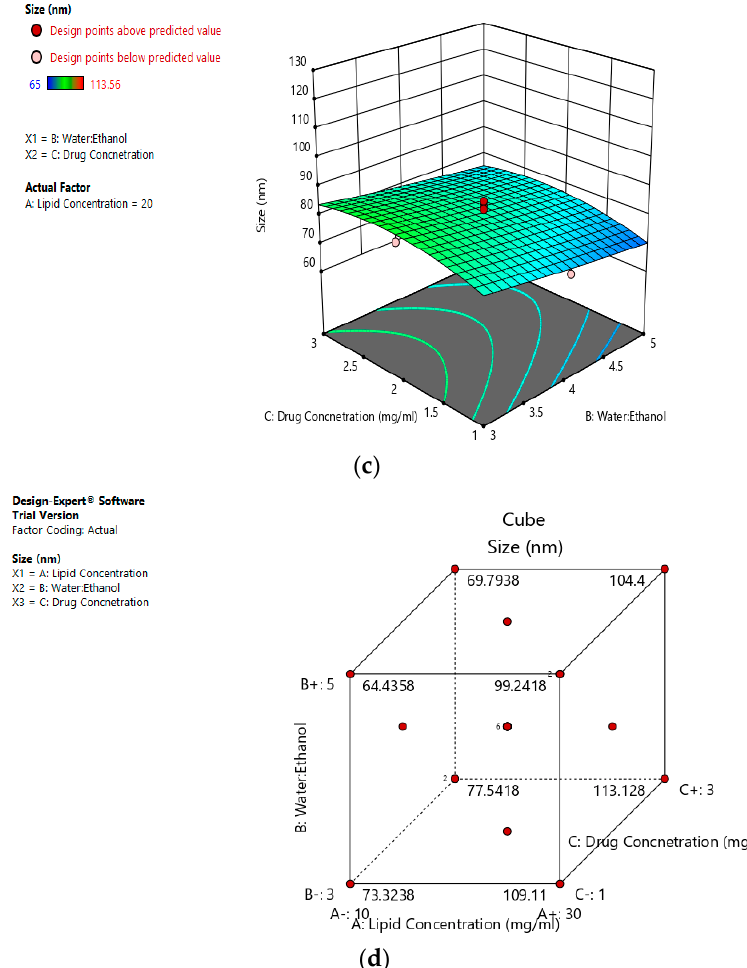
Figure 2. Effect of factors on the size of the dacarbazine liposomes (DL) ( a ) Effect of individual factors on Size; ( b ) Effect of combinations of two factors on Size (2D plots); ( c ) Effect of combinations of two factors on Size (3D plots); ( d ) Effect of all three factors on Size.